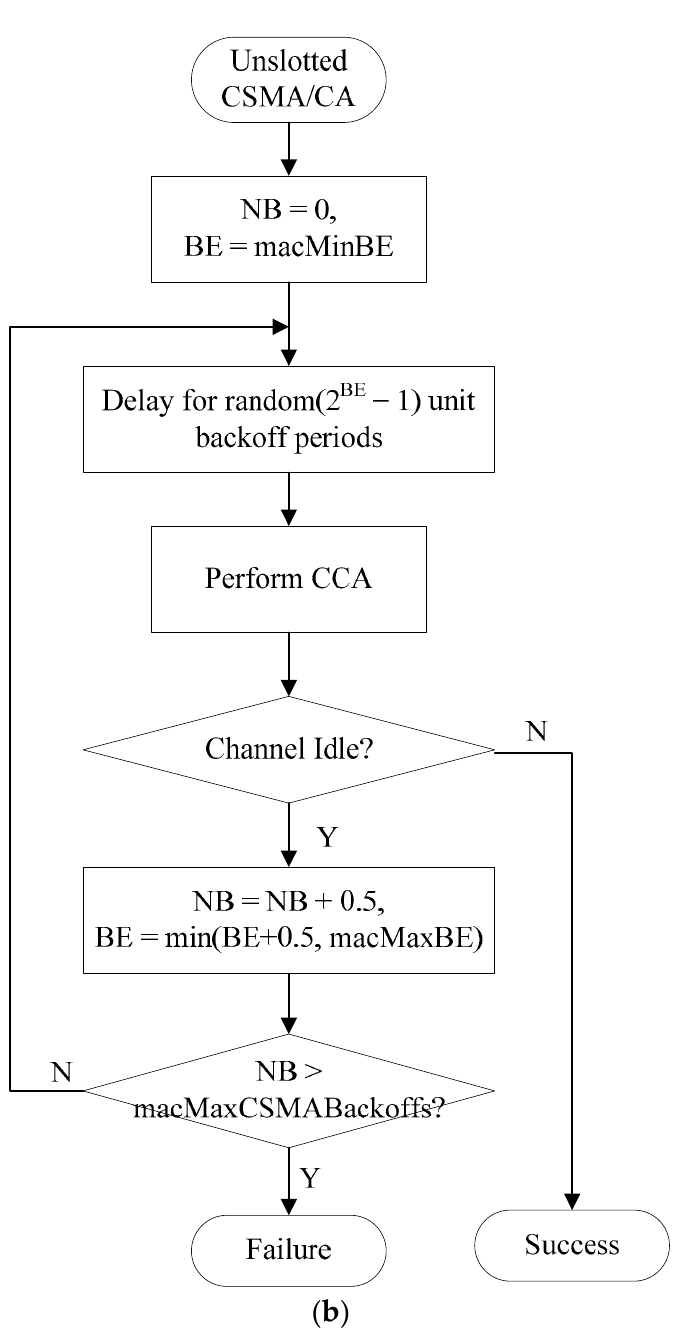
Figure 7. ( a ). The flowchart of the slotted CSMA/CA mechanism in the proposed E ‐ CAP. ( b ). The flowchart of the unslotted CSMA/CA mechanism in the proposed E ‐ CAP.